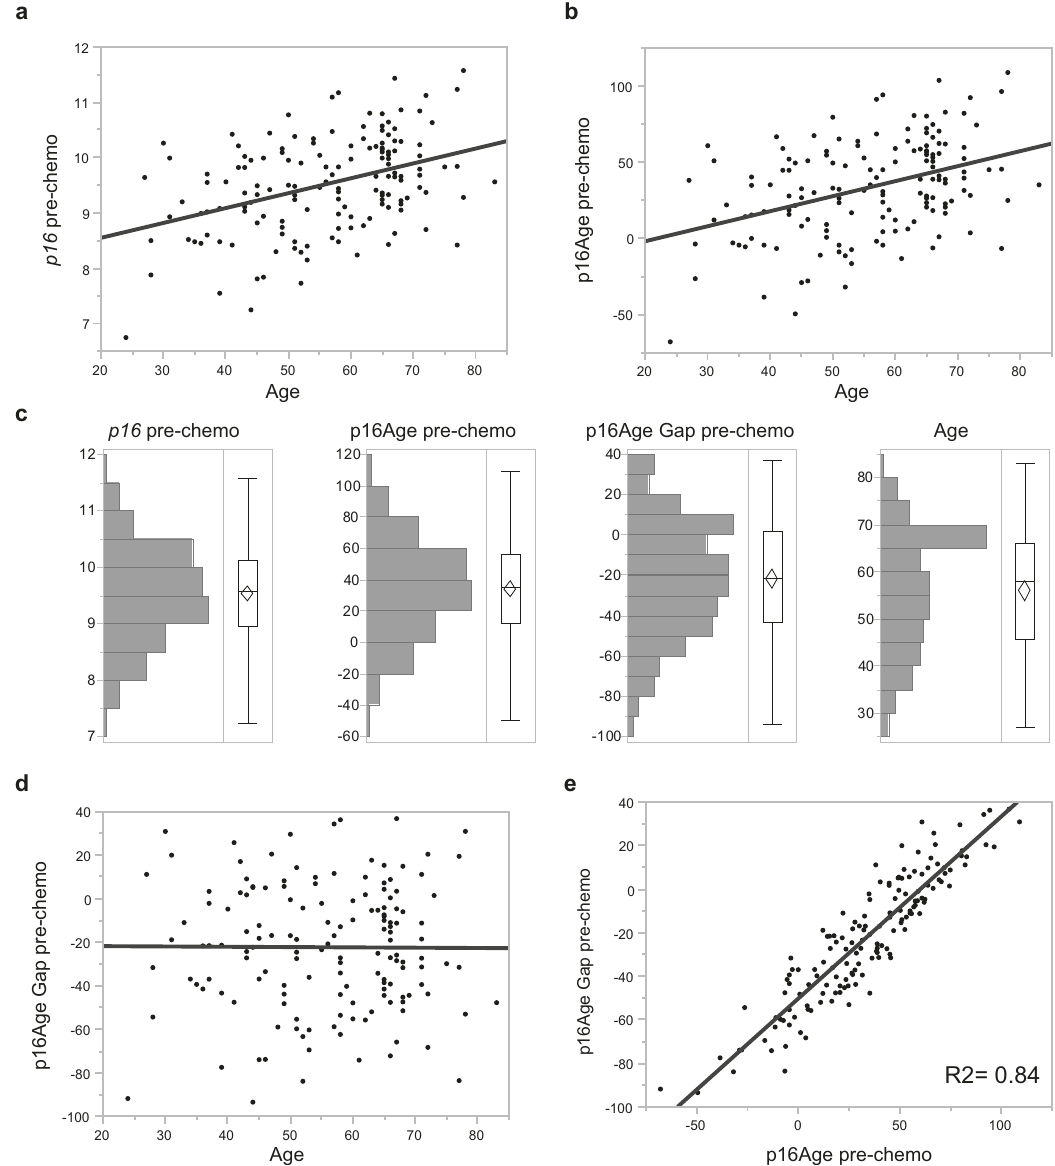
Fig. 1 Expession of p16 mRNA, p16Age, and p16Age Gap prior to chemotherapy. Correlation between chronological age and expression levels of p16 mRNA (log2) ( a ), calculated p16Age ( b ) and p16Age Gap ( d ) and 16Age and p16Age gap ( e ). Distribution of p16 , p16Age, p16Age Gap and chronological age are summarized in a histogram ( c ). The histogram shows a bar for grouped values of each continuous variable. The outlier box plot in each graph shows quantiles of continuous distributions. The horizontal line within the box represents the median sample value. The con fi dence diamond contains the mean and the upper and lower 95% of the mean. p16Age (and therefore log2 p16 ) is highly correlated with p16Age